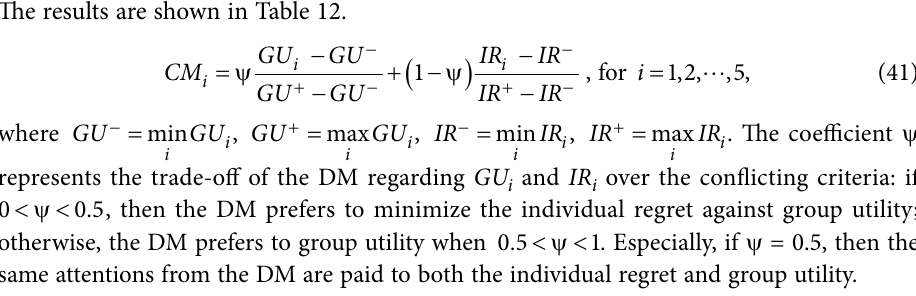
Table 11. Calculation results of GU i and IR i A 1 A 2 A 3 A 4 A 5 GU i 1.1211 0.9195 0.3806 0.9578 1.3138 IR i 0.3179 0.6018 0.1427 0.4519 0.5643